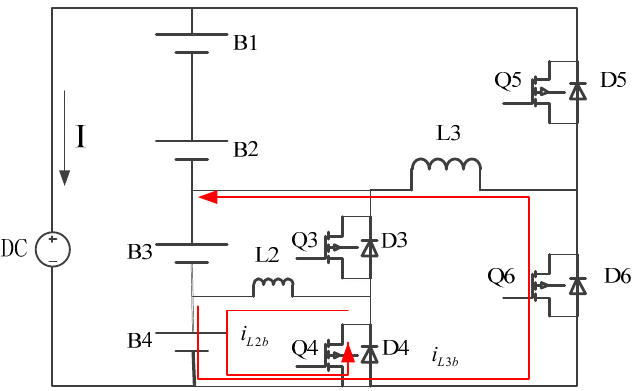
Figure 6. Schematic of the second stage of discharge equalization.